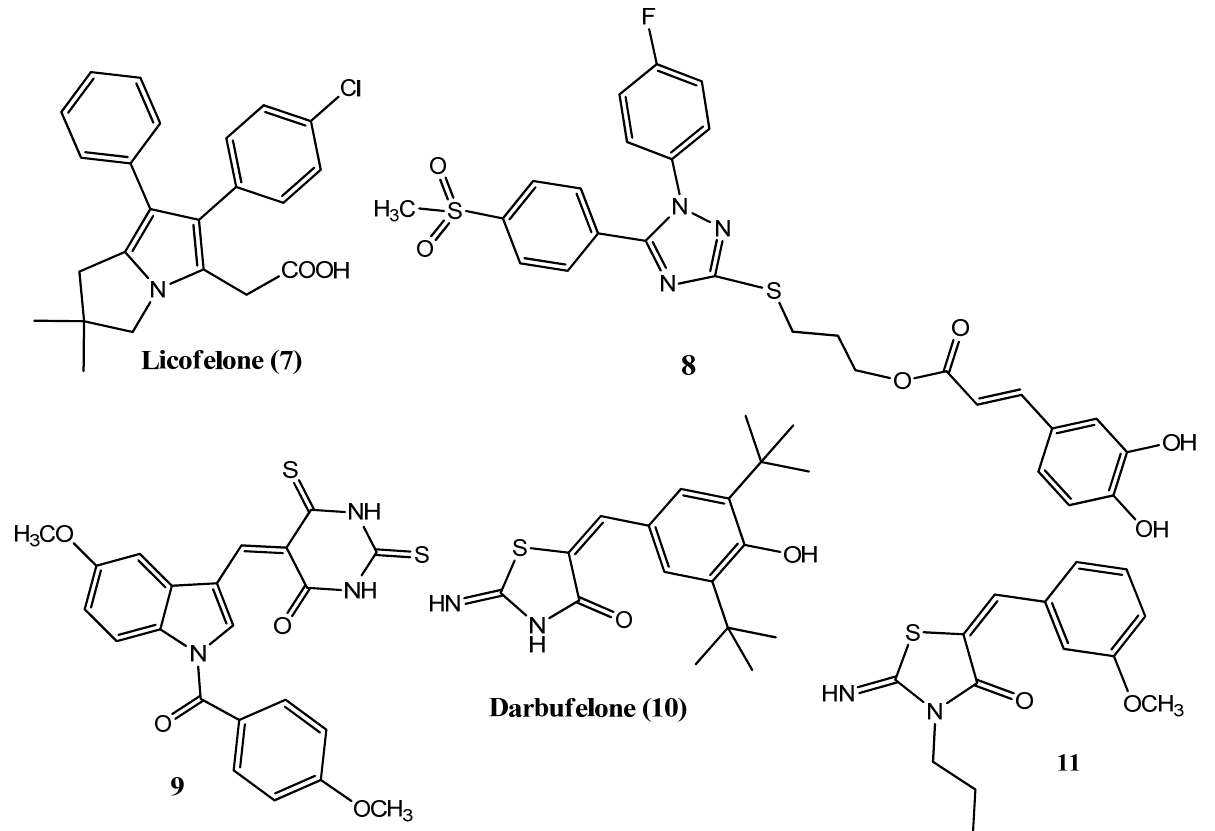
Figure 2. Structure of the lead compounds with anticancer and COX-2 inhibitory potentia